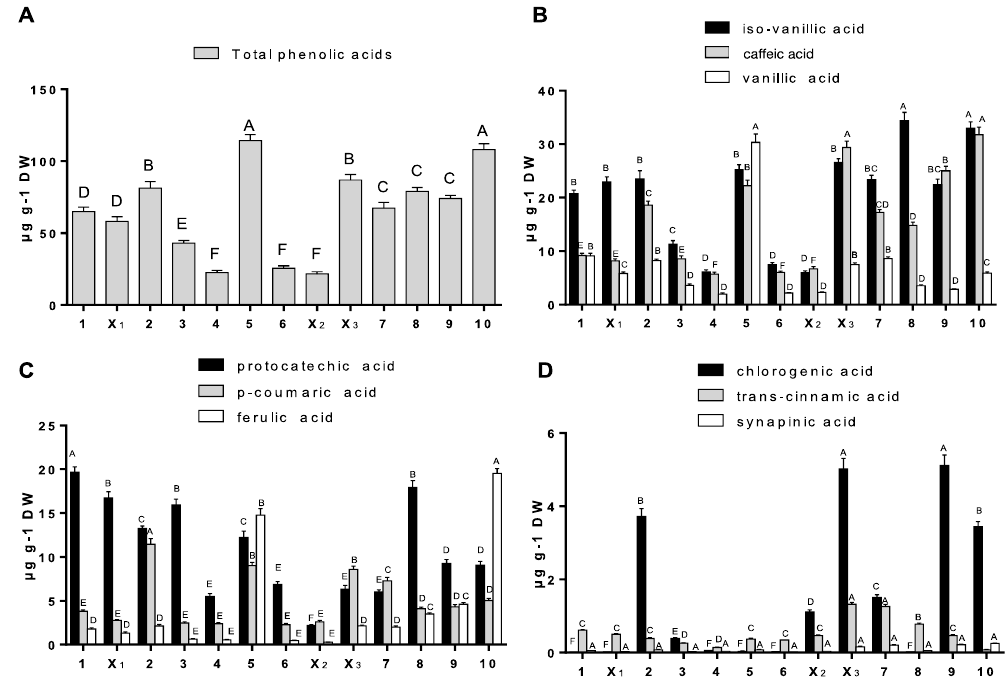
Figure 2. The concentration of total phenolic acids ( A ), including iso ‐ vanillic, caffeic and vanillic acid ( B ), protocatechuic, p ‐ coumaric and ferulic acid ( C ), chlorogenic, trans ‐ cinnamic and sinapinic acids ( D ). The values are means ( n = 3) ± SD. Symbols: 1–10–numbers of cultivars as in Table 1.